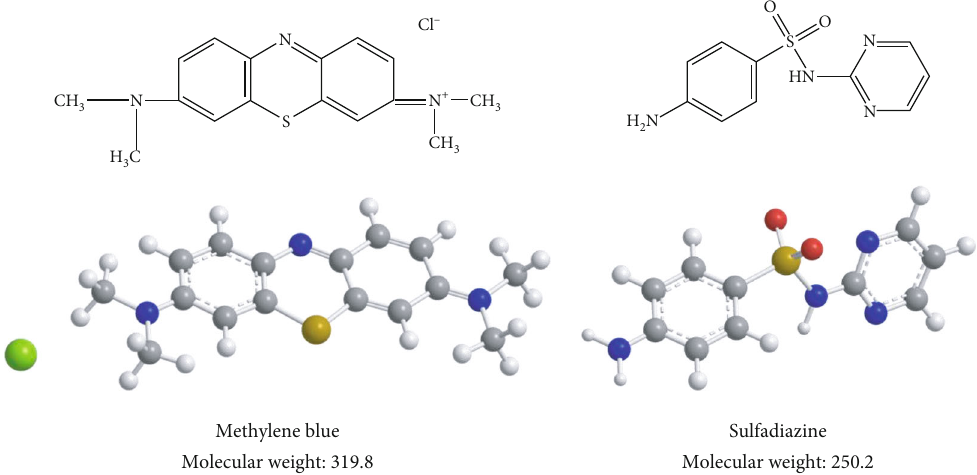
Figure 1: Methylene blue and sulfadiazine structural